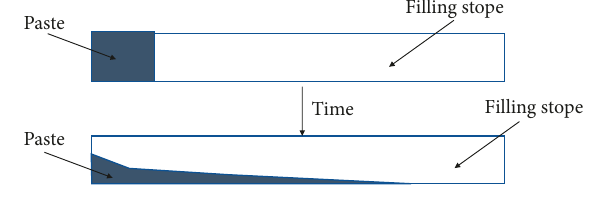
Figure 3: Schematic diagram of paste flowing in